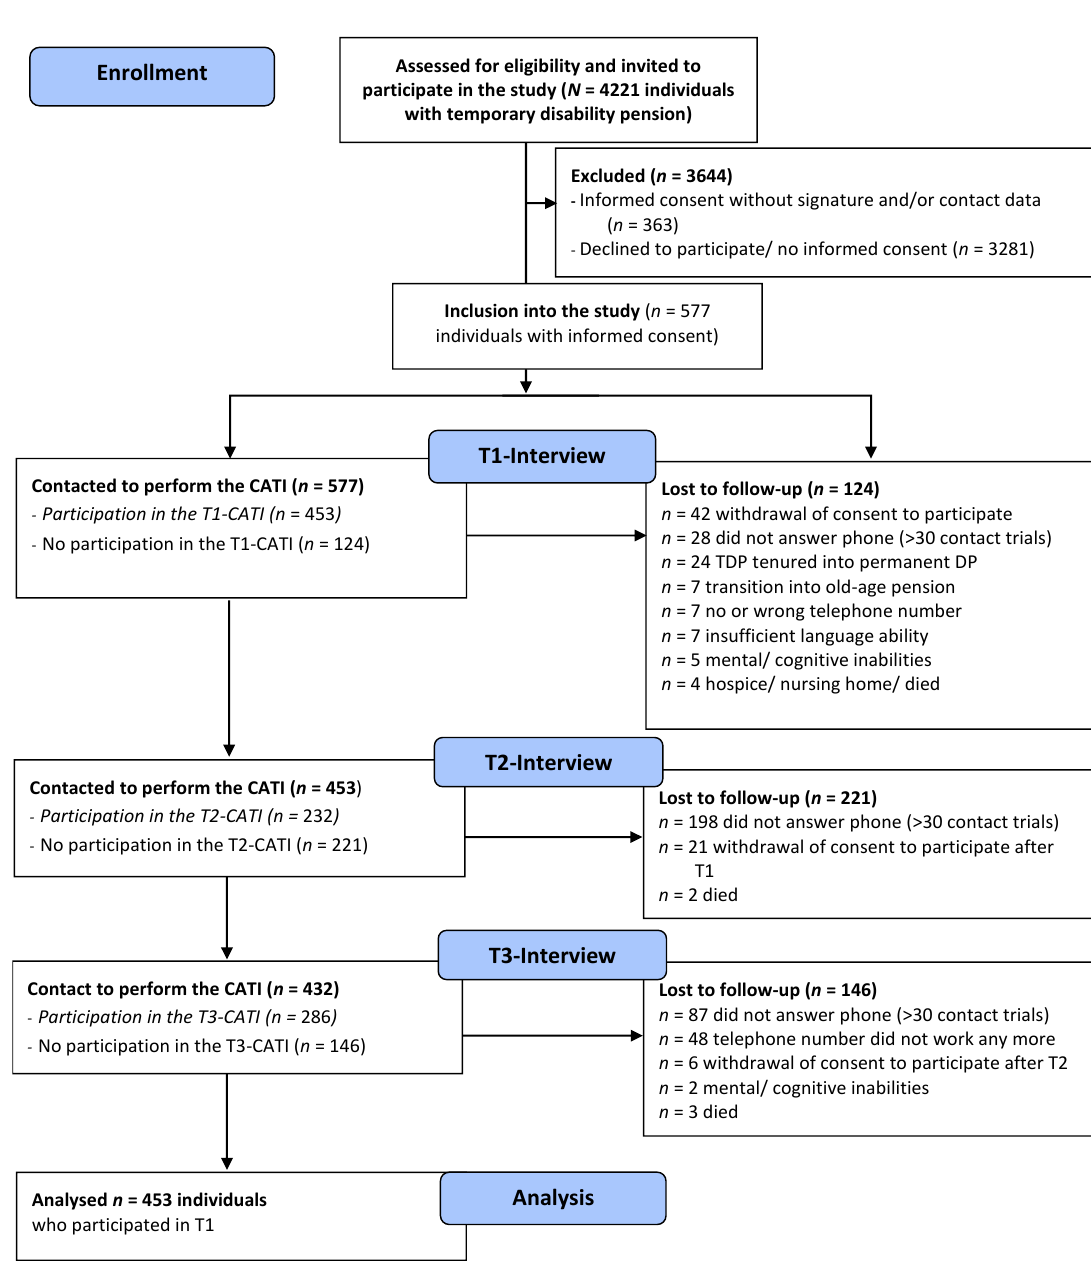
Figure 1. Consort flow diagram.